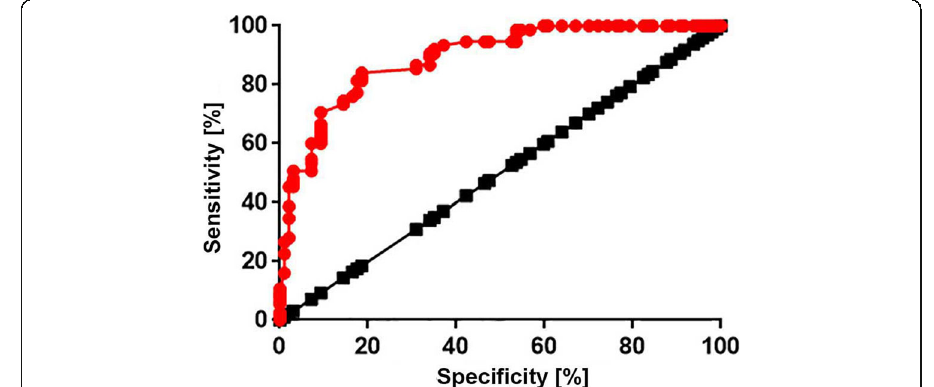
Fig. 2 ROC curve analysis of the diagnostic value of serum lncRNA-ATB for osteoarthritis. ROC curve analysis was performed with osteoarthritis patients as true positive samples and healthy controls as true negative samples. The results showed that upregulated serum levels of lncRNA-ATB effectively distinguished osteoarthritis patients from healthy